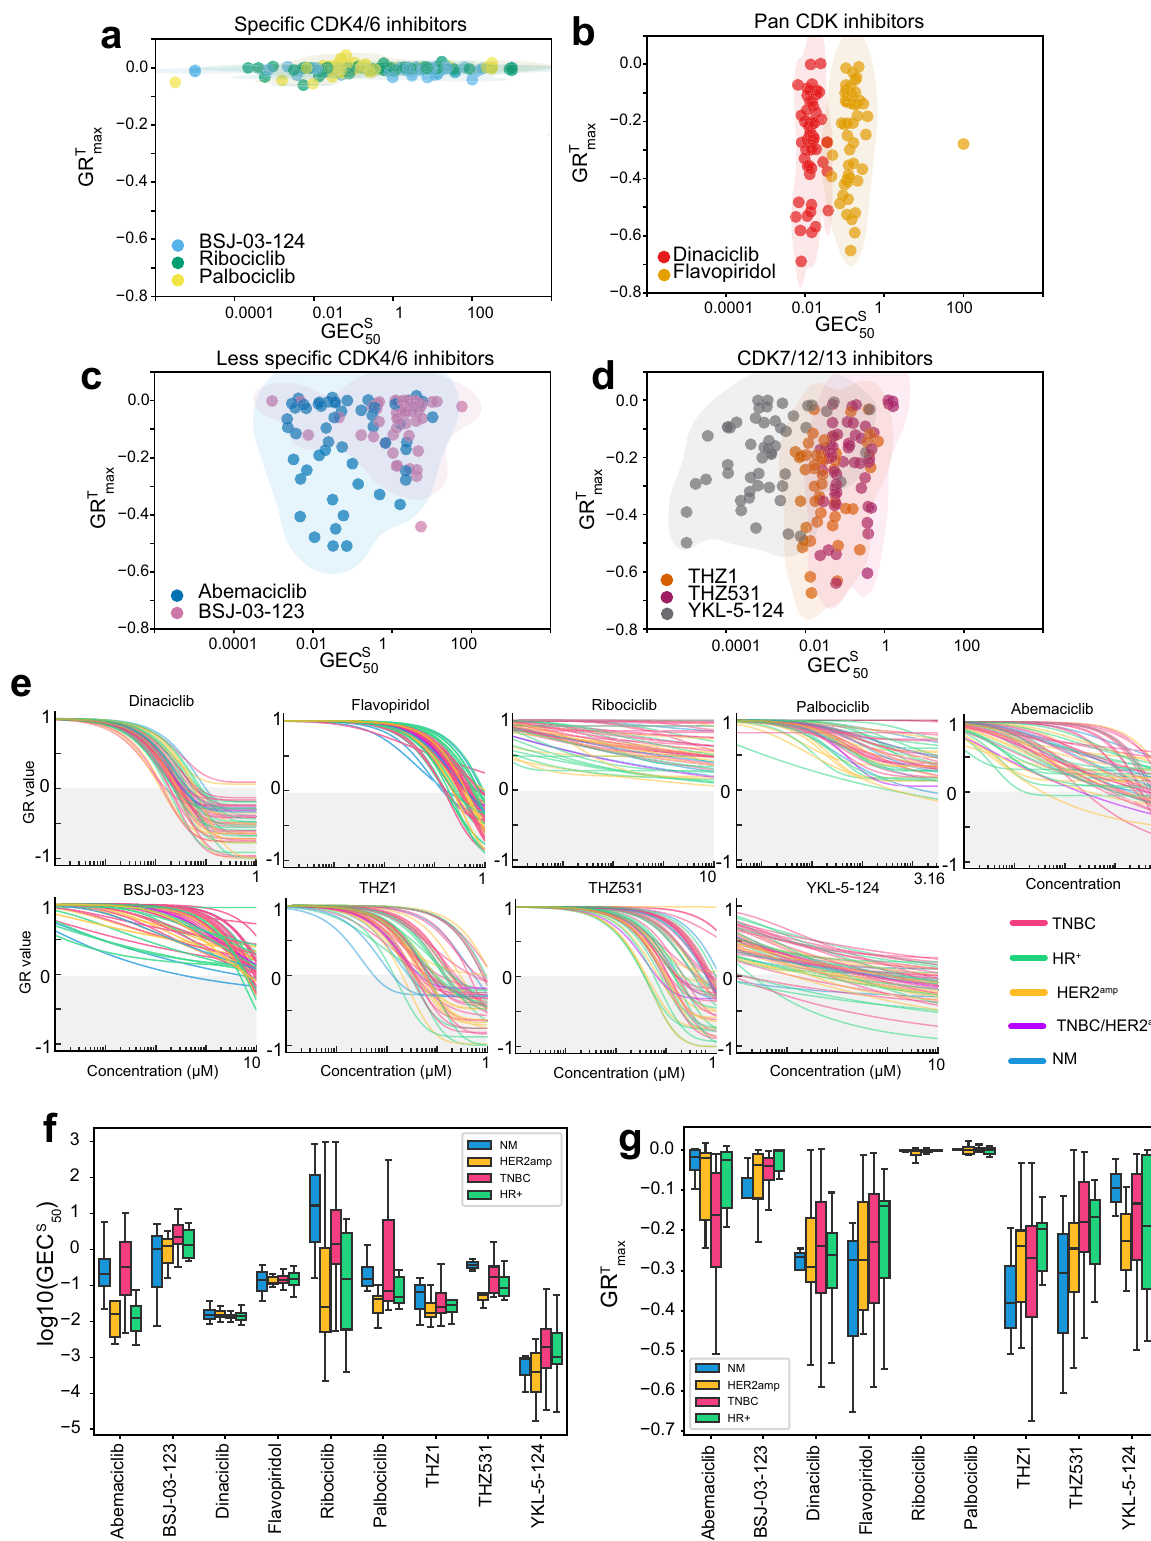
Fig.5|VariationinstaticandtoxiccomponentsofresponsestoCDKinhibitors. a Relationship between GR T max and GEC S 50 for drugs targeting CDK4/6, b pan- CDKs, c CDK4/6andoff-targets,and d CDK7/12/13.Shadingisforvisualizationonly. e The GR dose-response curves for the same conditions shown in ( a – d ) 72h after drug addition. Summary boxplots of f GEC S 50 and g GR T max values by subtype for